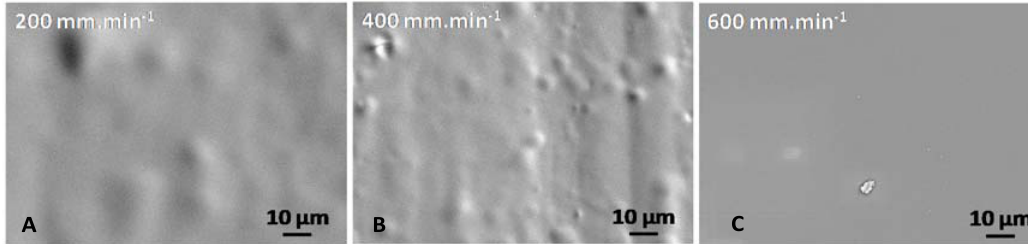
Figure 9. Coating surface micrographs for bilayer systems by SEM performed for deposits with various withdrawal speeds ( A ) 200 mm · min − 1 ; ( B ) 400 mm · min − 1 and ( C ) 600 mm min − 1 .